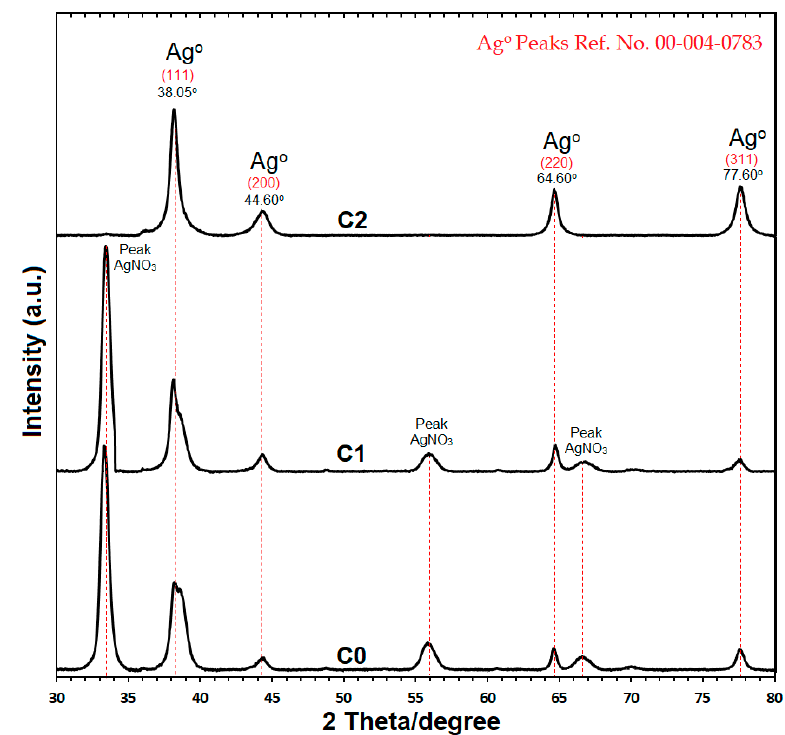
Figure 5. Powder X-ray diffraction pattern for C2, C1, and C0 samples.